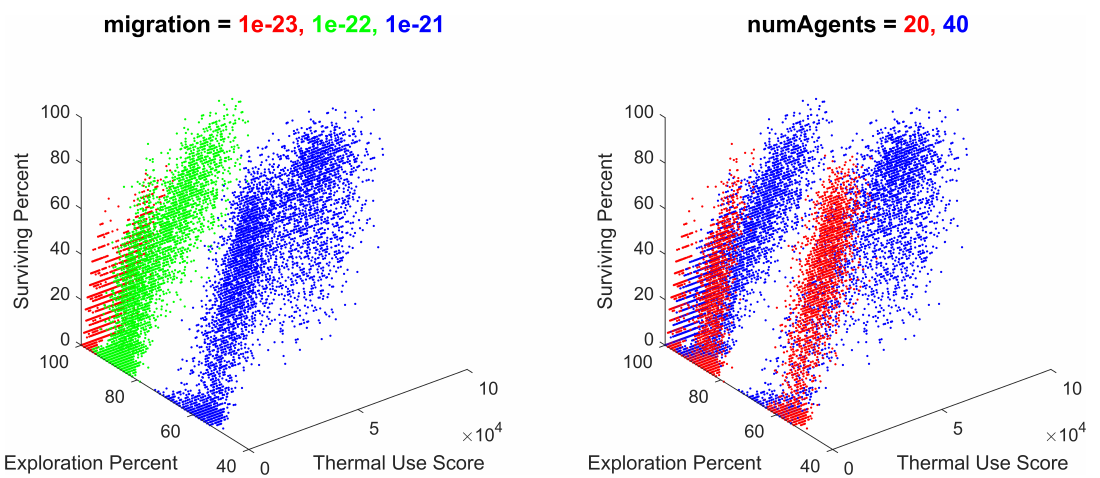
Figure 16. All batch simulation data plotted for thermal use, exploration percentage, and survival percentage, colored for migration values of 1 × 10 − 23 , 1 × 10 − 22 , and 1 × 10 − 21 and for initial number of agents values of 20 and 40. Note the distinct clumping within the plots, resulting from each unique value of migration and initial number of agents.